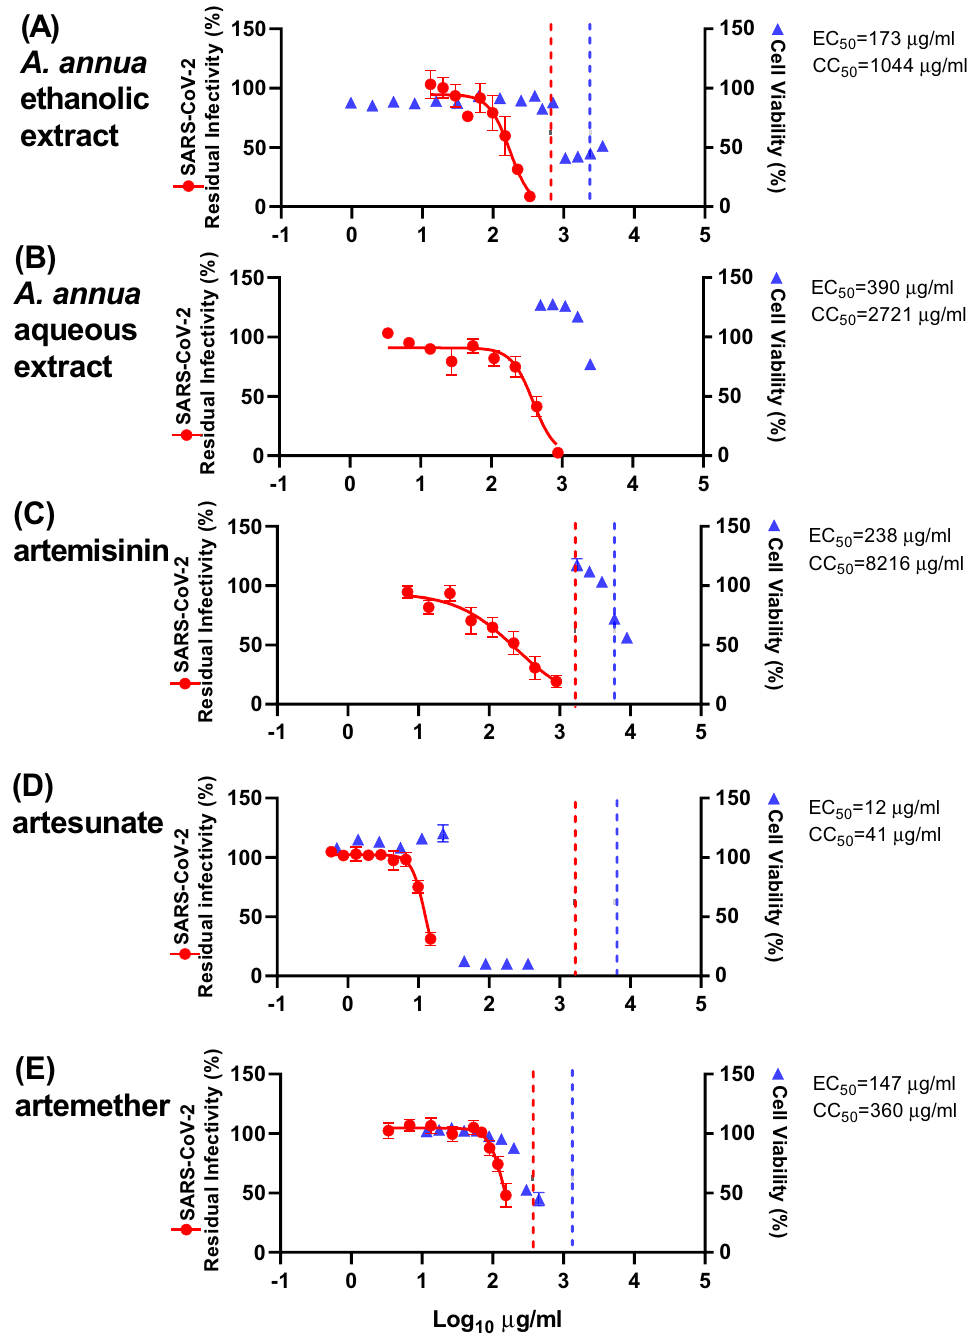
Figure 2. Pretreatment efficacy of extracts and compounds against SARS-CoV-2 in a concentration–response antiviral treatment assay in VeroE6 cells. VeroE6 cells seeded the previous day in 96-well plates were treated with the specified concentrations of extracts ( A ) A. annua ethanolic extract, and ( B ) A. annua aqueous extract, or compounds artemisinin ( C ), artesunate ( D ), and artemether ( E ) for 1.5 h prior to infection with SARS-CoV-2. After a 2-day incubation, infected cells were visualized by immunostaining for SARS-CoV-2 spike glycoprotein and counted automatically as described in “Materials and methods”. % residual infectivity for individual wells was calculated by relating counts of infected treated wells to the mean count of 14 infected nontreated control wells. Datapoints (red dots) are means of seven replicates with standard errors of the means (SEM) obtained in one representative experiment. Sigmoidal dose response curves (red lines) were fitted and EC 50 values were calculated in GraphPad Prism as described in “Materials and methods”. % Cell viability and CC 50 values were determined in replicate assays without infection with SARS-CoV-2 as described in “Materials and methods”. Datapoints (blue triangles) are means of 3 replicates with SEM obtained in one representative experiment. The dotted red/blue lines indicate the concentrations at which an antiviral effect (< 70% residual infectivity)/ cytotoxic effect (< 90% cell viability) due to DMSO is expected according to Figure